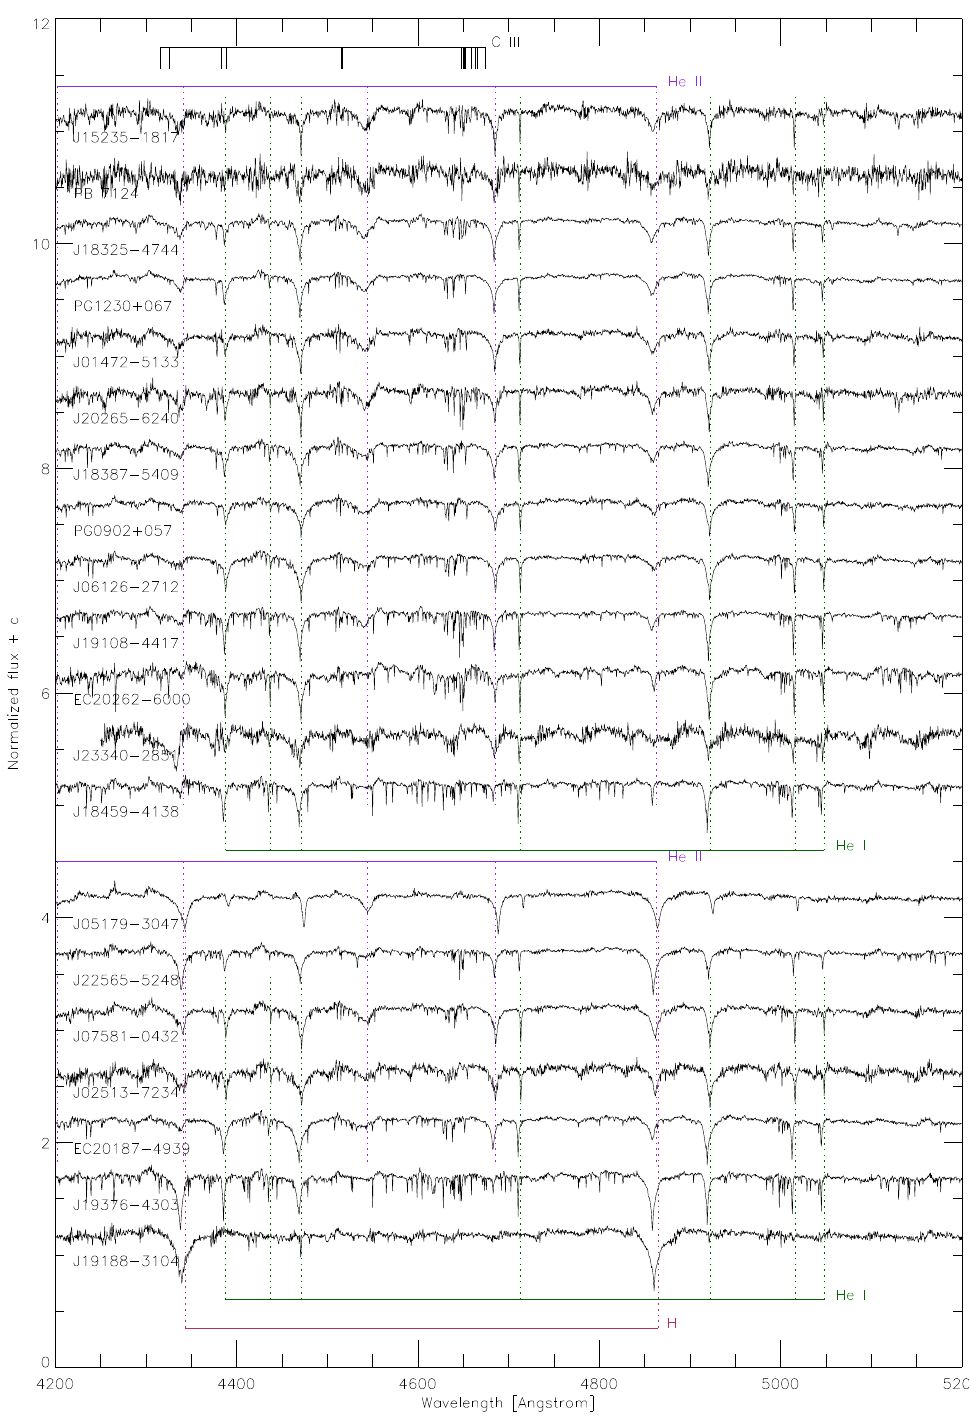
Figure 2. Blue SALT/HRS atlas of hot subdwarfs binned to show major hydrogen and helium lines. Seven stars at the bottom of the panel show significant hydrogen. Above the break, all stars are helium-rich, and have been arranged approximately in order of increasing He ii /He i (upwards). The rest wavelengths of principal hydrogen, helium and carbon lines are indicated. The spectra have not been cor- rected for velocity shifts. All wavelengths are in